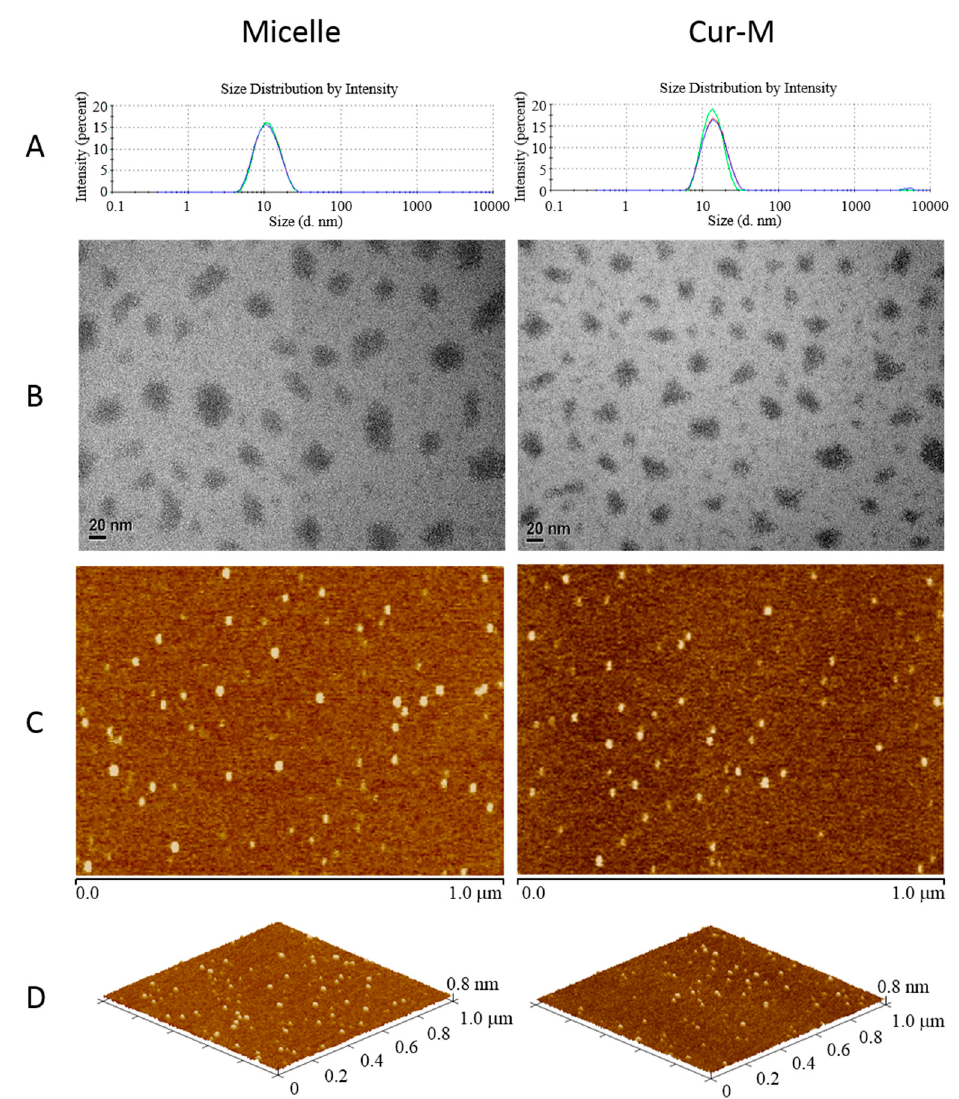
Figure 2. Size distributions and morphologies of void micelles and Cur-M. ( A ) Particle size distribution was determined by dissolving 10 mg samples in 2 mL of double distilled water (ddH 2 O) and was analyzed by dynamic light scattering (DLS) at 25 ◦ C. ( B ) TEM images were acquired by dissolving 10 mg samples in 50 mL of ddH 2 O and negative staining with 0.5% phosphotungstic acid (PTA). AFM ( C ) phase images and ( D ) 3D images were acquired by dissolving 10 mg samples in 2 mL of water and then dropping 20 µL of the sample solution onto a silicon chip.